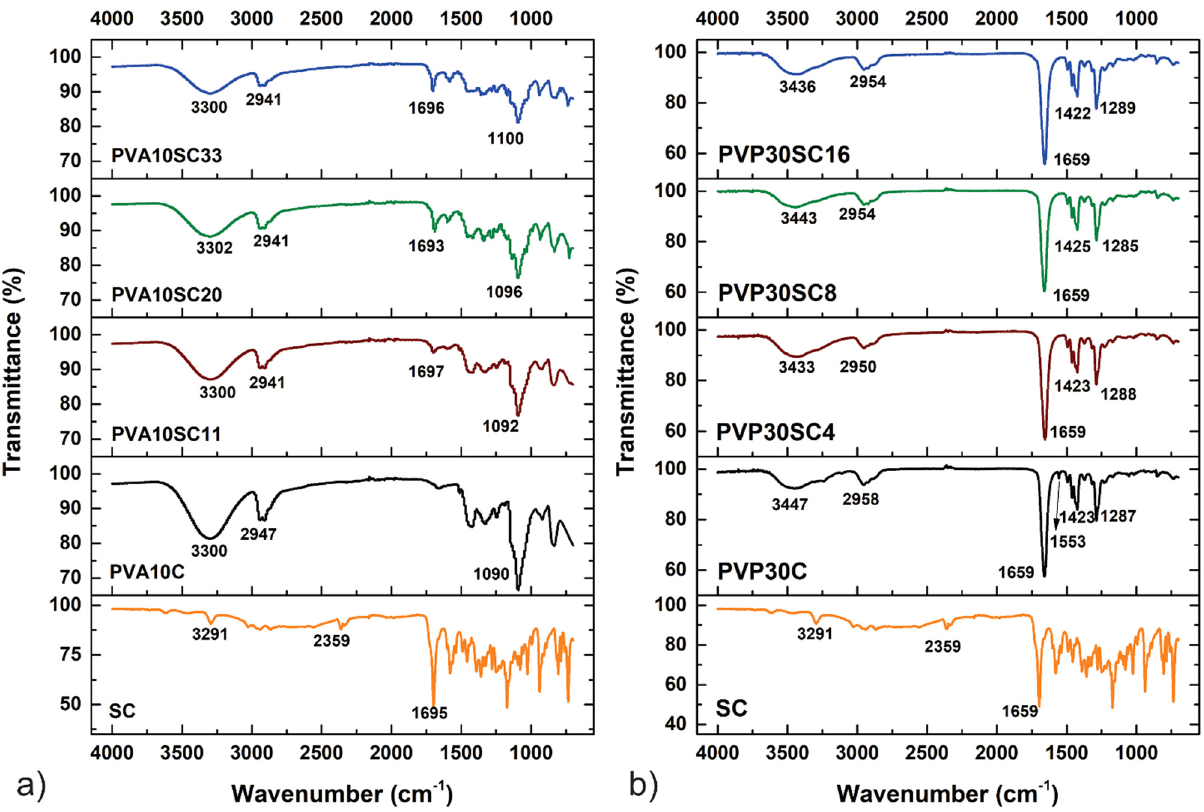
Figure 1: FTIR spectra comparison of PVA/SC and PVP/SC fi brous sca ff olds. ( a ) PVA/SC fi bers, and SC spectra; ( b ) PVP/SC fi bers and SC